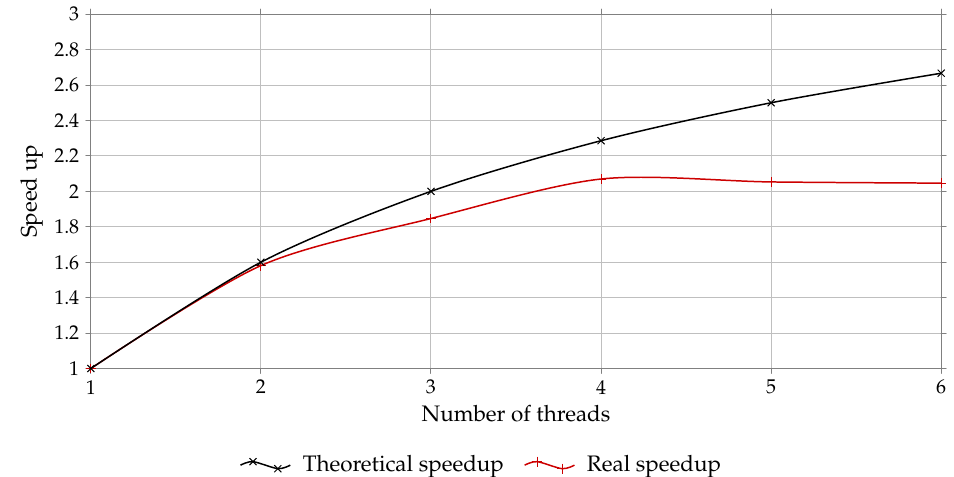
Figure 9. Time cost with different number of